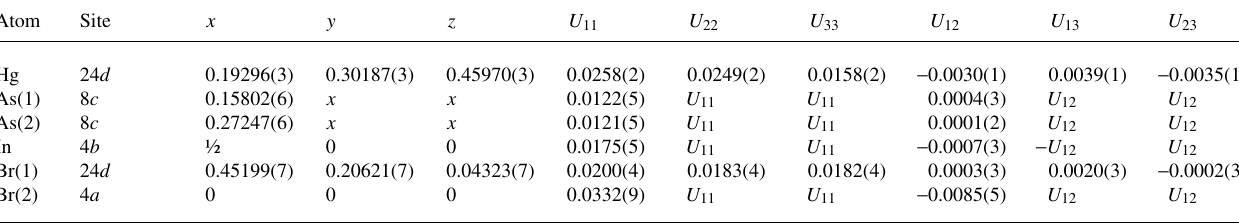
Table 2. Atomic coordinates and displacement parameters (in Å 2 ) . Atom Site